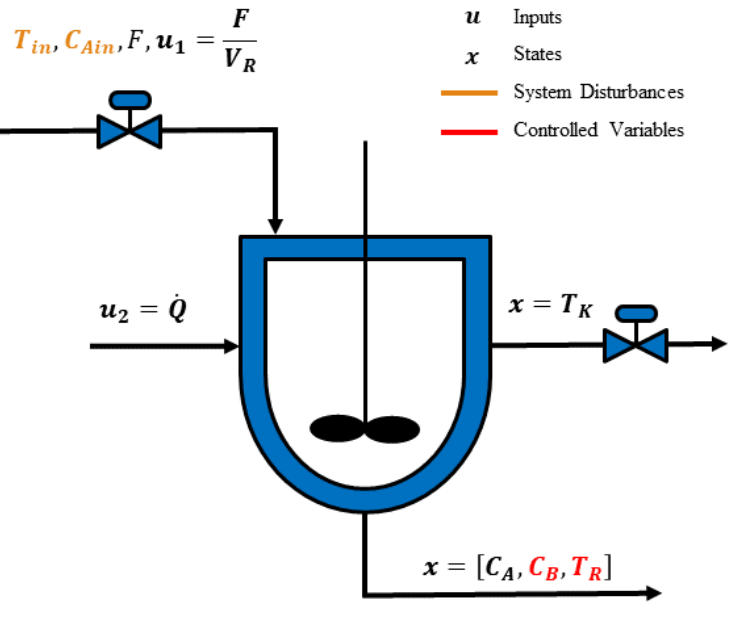
Figure 2. Van de Vusse reactor